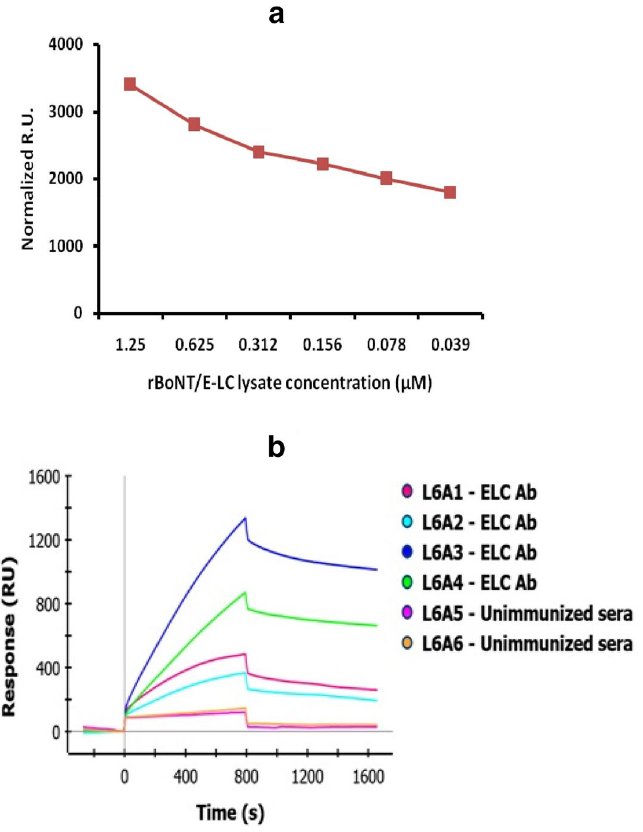
Figure 4. The affinity of antibodies was determined by SPR, His tagged rBoNT/E-LC lysate immobilized on HTG chip: ( A ). The plot here illustrates the lysate binding on the HTG chip in 6 different concentration ranging from 1.25–0.039 μg. ( B ). Sensorgrams obtained for the binding of mice antibodies to immobilized rBoNT/E-LC using ProteOn XPR36 system. The mice antibodies were injected at four different concentrations (shown in different colours) ranging from (7.2–0.0072 μM) and negative control in duplicates. The high RU signifies the greater binding affinity of mice antibodies with rBoNT/E-LC as depicted in graph while unimmunized sera (pink, brown color) showing the fastest dissociation and low RU.